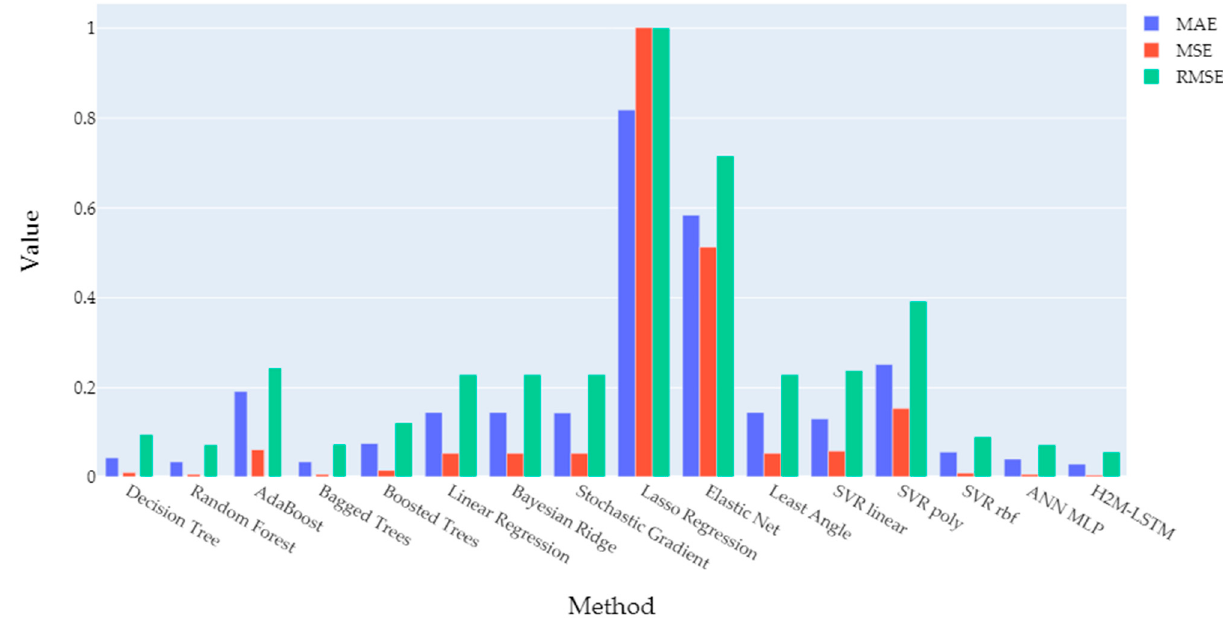
Figure 11. Barplot comparison of the performance metrics for the heat storage tank.